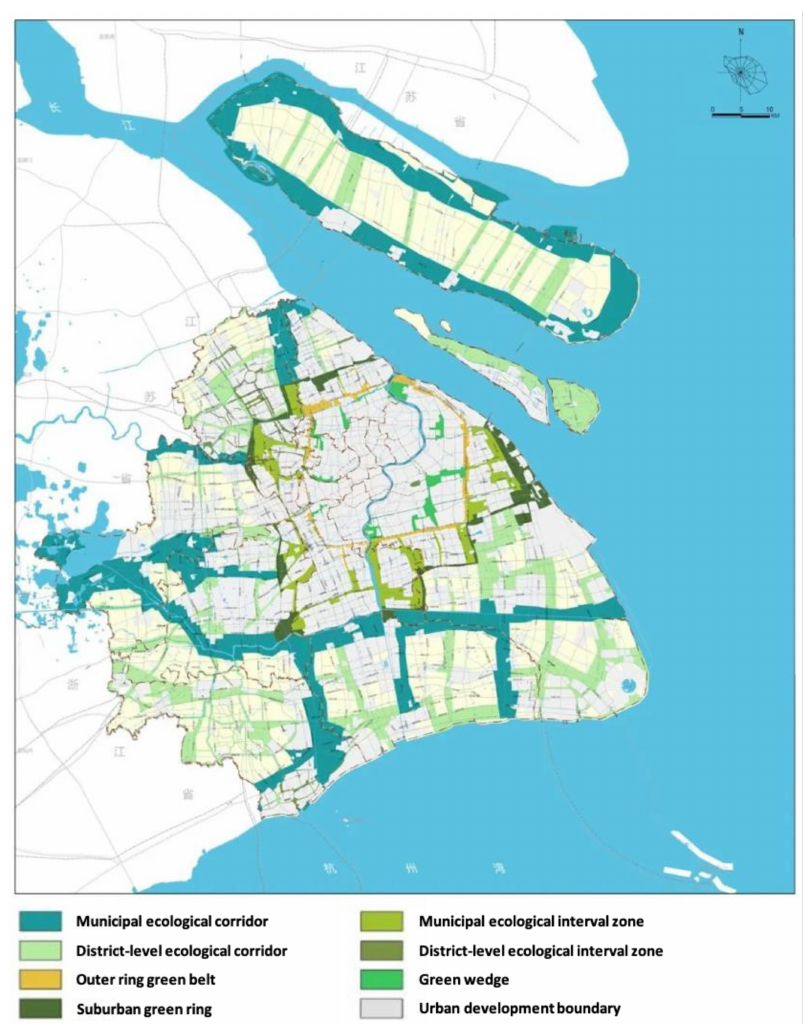
Figure 4. Shanghai Ecological Protective Plan (draft version) in 2020